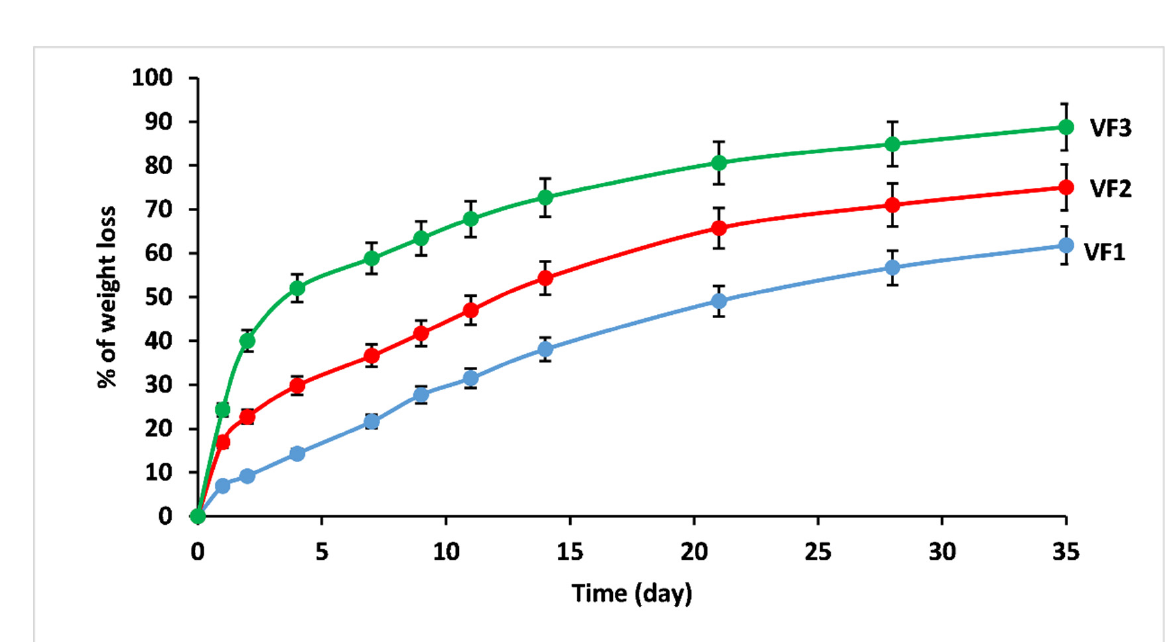
Figure 6. Trend of weight loss for concentrations of [K 2 O/(CaO+MgO)] ratio (%mol). VF1: 0.67 %mol, VF2: 1.33 %mol and VF3: 2